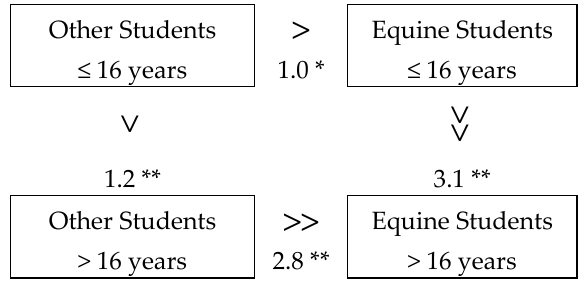
Figure 2. Difference of mean of the behavior problem (BP) between each group. * p < 0.050; ** p < 0.001 (asterisks (*) are according to the ANOVA Scheffe post hoc test).